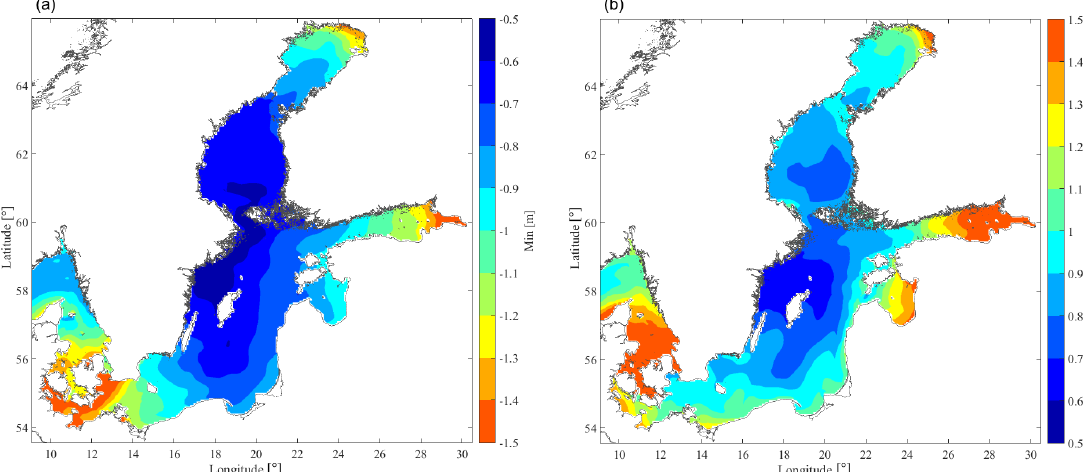
Figure 9. Lowest minima (a) and highest maxima (b) of the SSH 1h during the period 2007 to 2016, after subtracting the mean value.